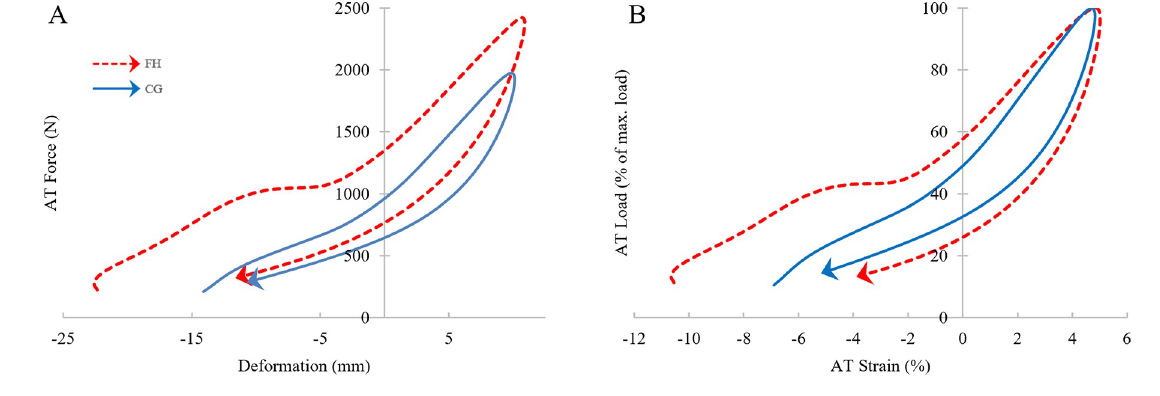
Fig 1. Absolute force-deformation (A) and normalized force-strain curves (B) . (A) AT Force depicted in N and displacement in mm change in length relative to length at heelstrike. (B) Curve is normalized to allow for direct visual comparison, AT load is shown as percent of peak AT force and AT strain is shown as the percent change in length relative to length at heelstrike. Dashed line represents FH, solid line represents CG; arrow heads depict loop direction; data relating to AT force values below 200 N were removed for clarity (high GRF variability at low force levels).